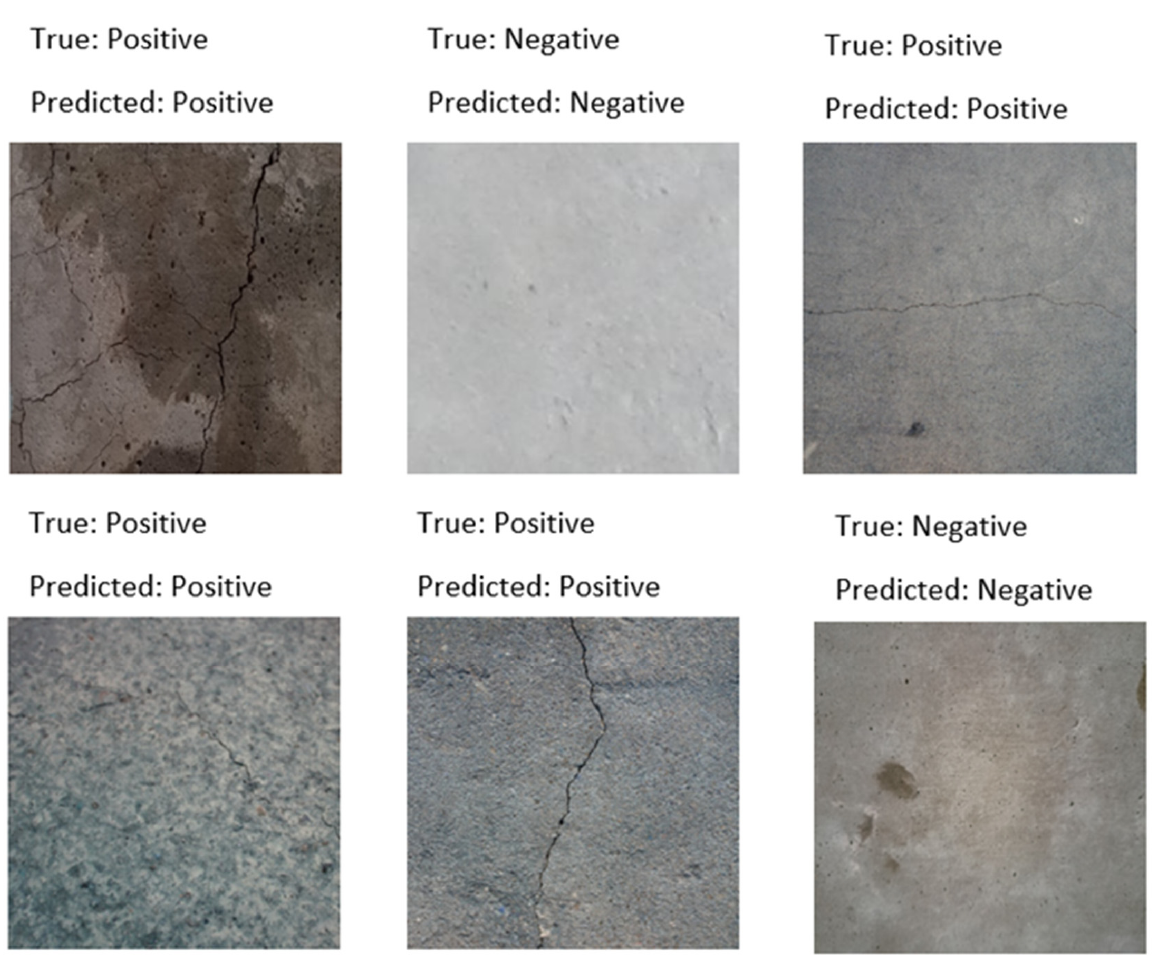
Figure 10. Sample classi fi cation result on test images by the VGG19 architecture.